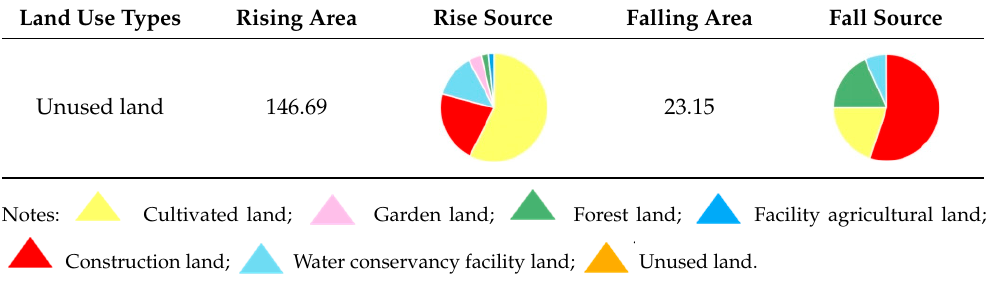
Figure 6. Falling graphics of land use in the ecological corridors of Jinshan District. (Note: the legend “cultivated land (-)” represents the spatial distribution of cultivated land transformed into other land types, and other legends follow the same rules.)